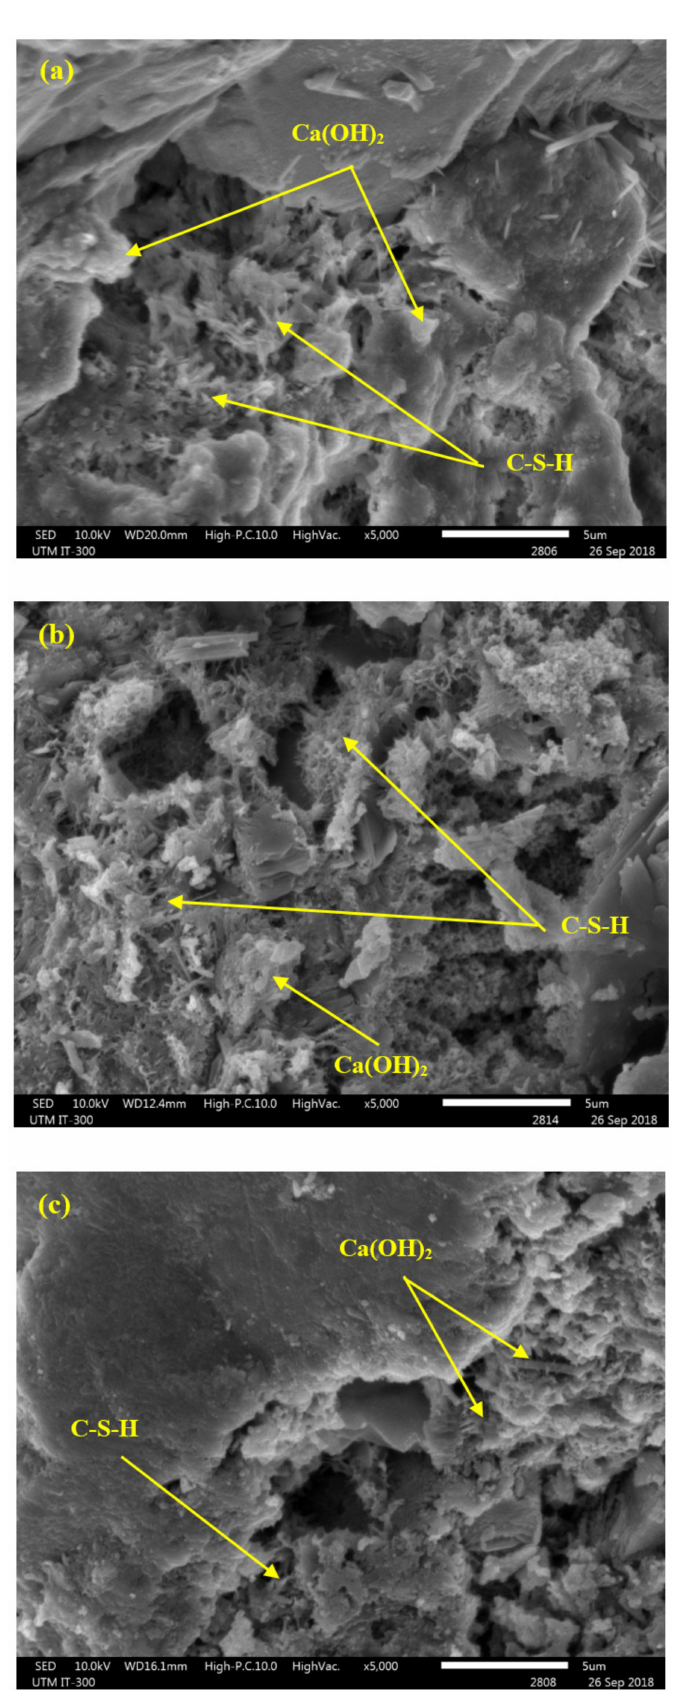
Figure 6. SEM images of ( a ) MC1-0-0, ( b ) MC2-50-0 and ( c ) MC4-50-10 at 28